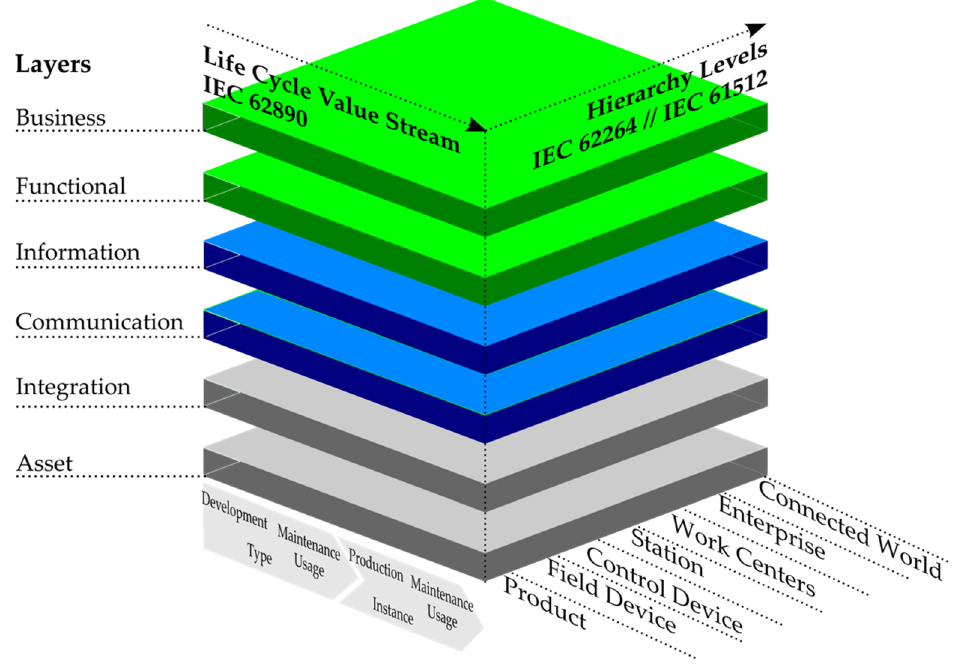
Figure 3. Reference Architectural Model for Industry 4.0 (RAMI 4.0). International Electrotechnical Commission (IEC).